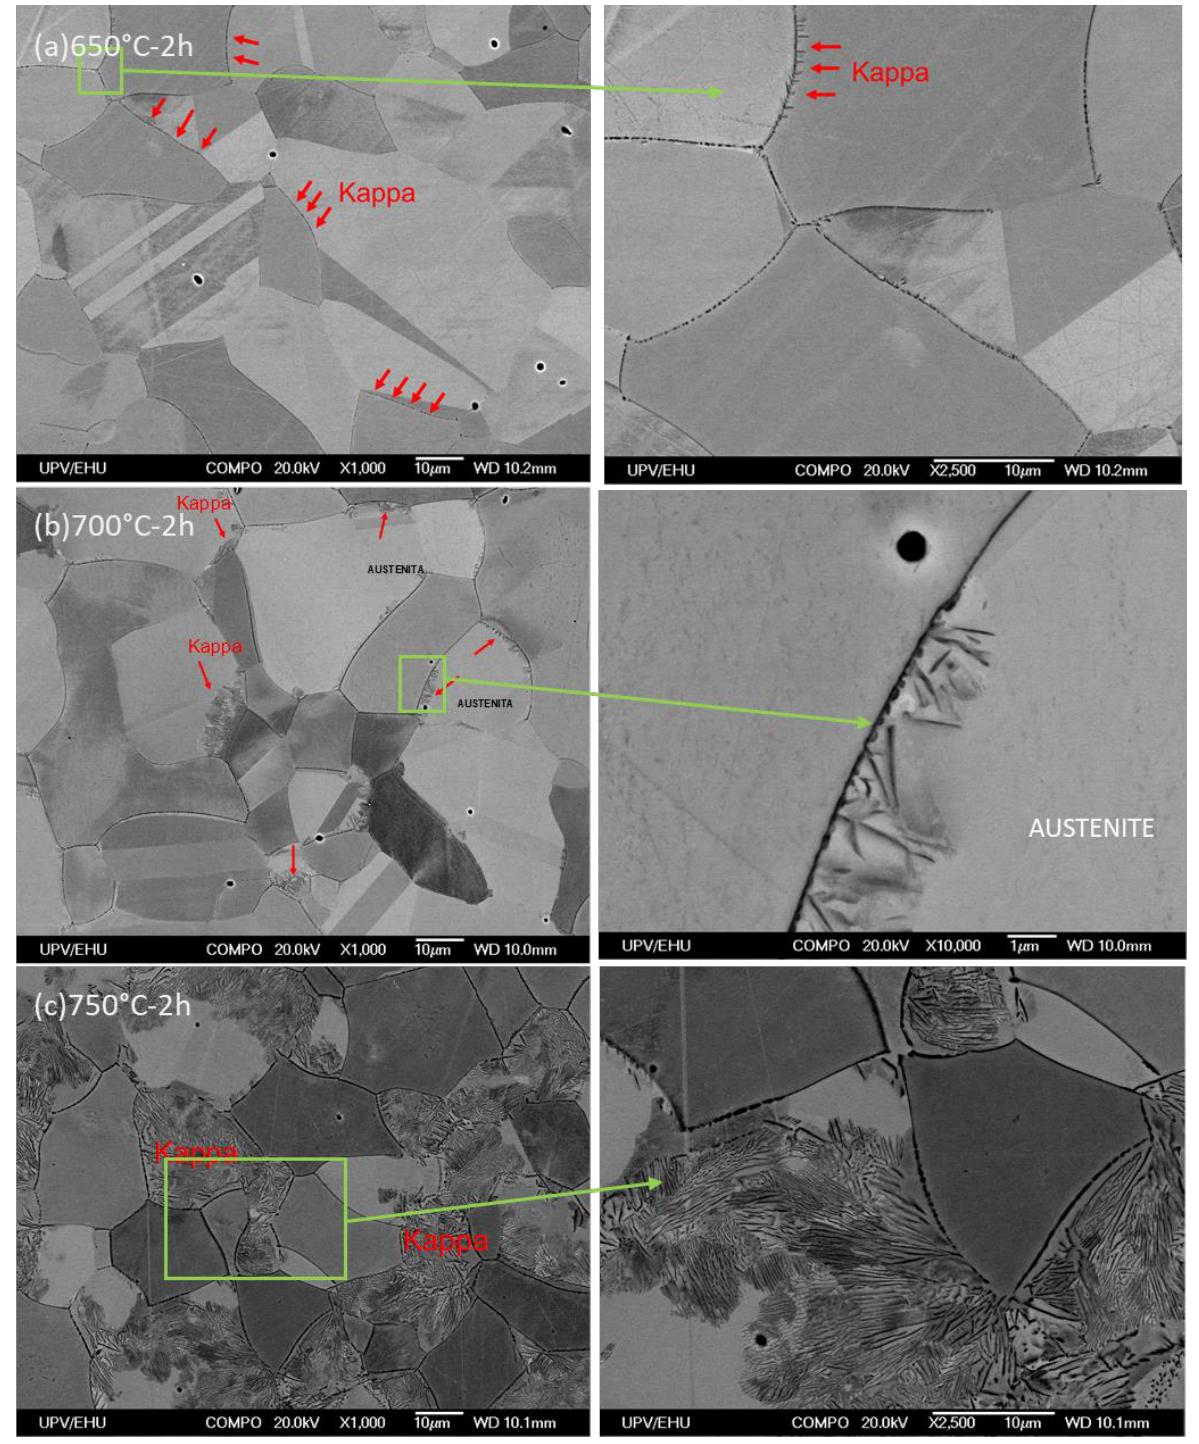
Figure 8. SEM micrographs of the alloy after 2 h of heat treatment at ( a ) 650 °C, ( b ) 700 °C and ( c ) 750 °C.